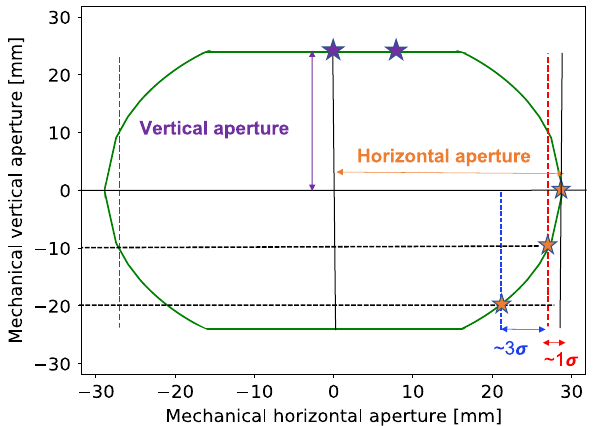
FIG. 14. Q3R5 geometrical aperture. The added star points and lines at different impacting points at the geometrical aperture illustrate the effect of a kick on the orthogonal to the measure- ment plane for different